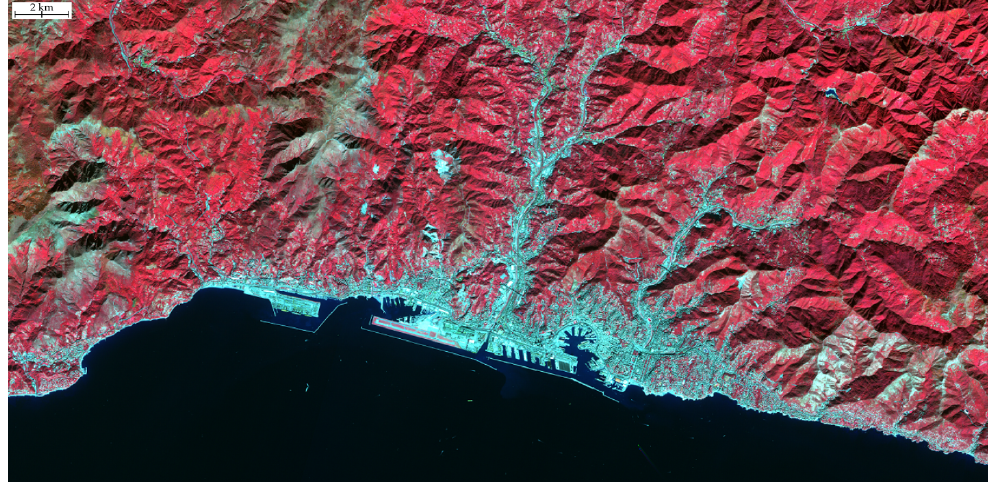
Figure 5. Sentinel-2 image of the city of Genoa, Italy: false colour composite of the near-infrared, red, and green channels after histogram